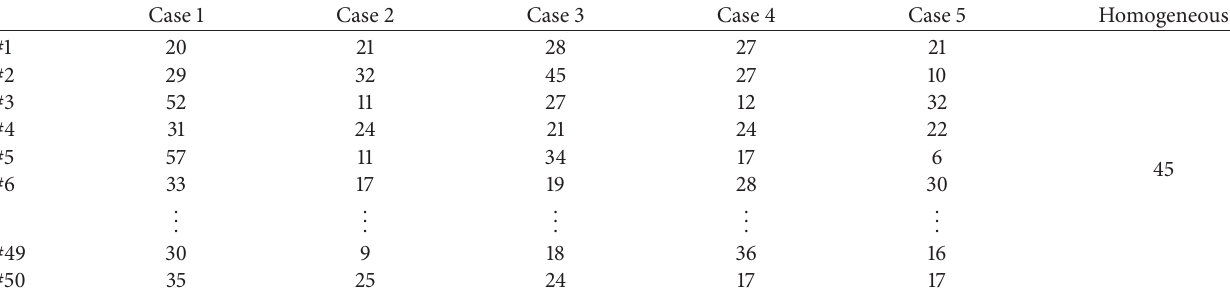
Figure 3: Comparison of water saturations between nontreated waterflooding and gel-treated waterflooding at 640 days. Table 6: Produced water-oil ratio after gel treatment at 1,000 days.